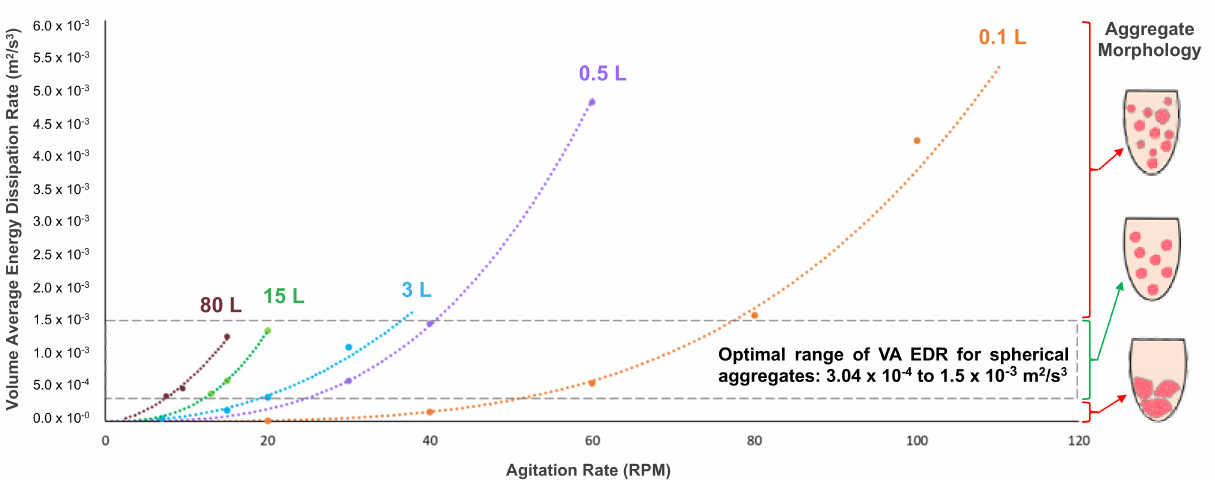
Figure 3. Curves to determine average EDR based on VW bioreactor working volume and agitation rate. Average EDR can be used to predict aggregate morphology for a particular combination of volume and agitation, with desired spherical aggregates as consequence of average EDR within an optimal range. Adapted from Dang et al. (2021) [28].